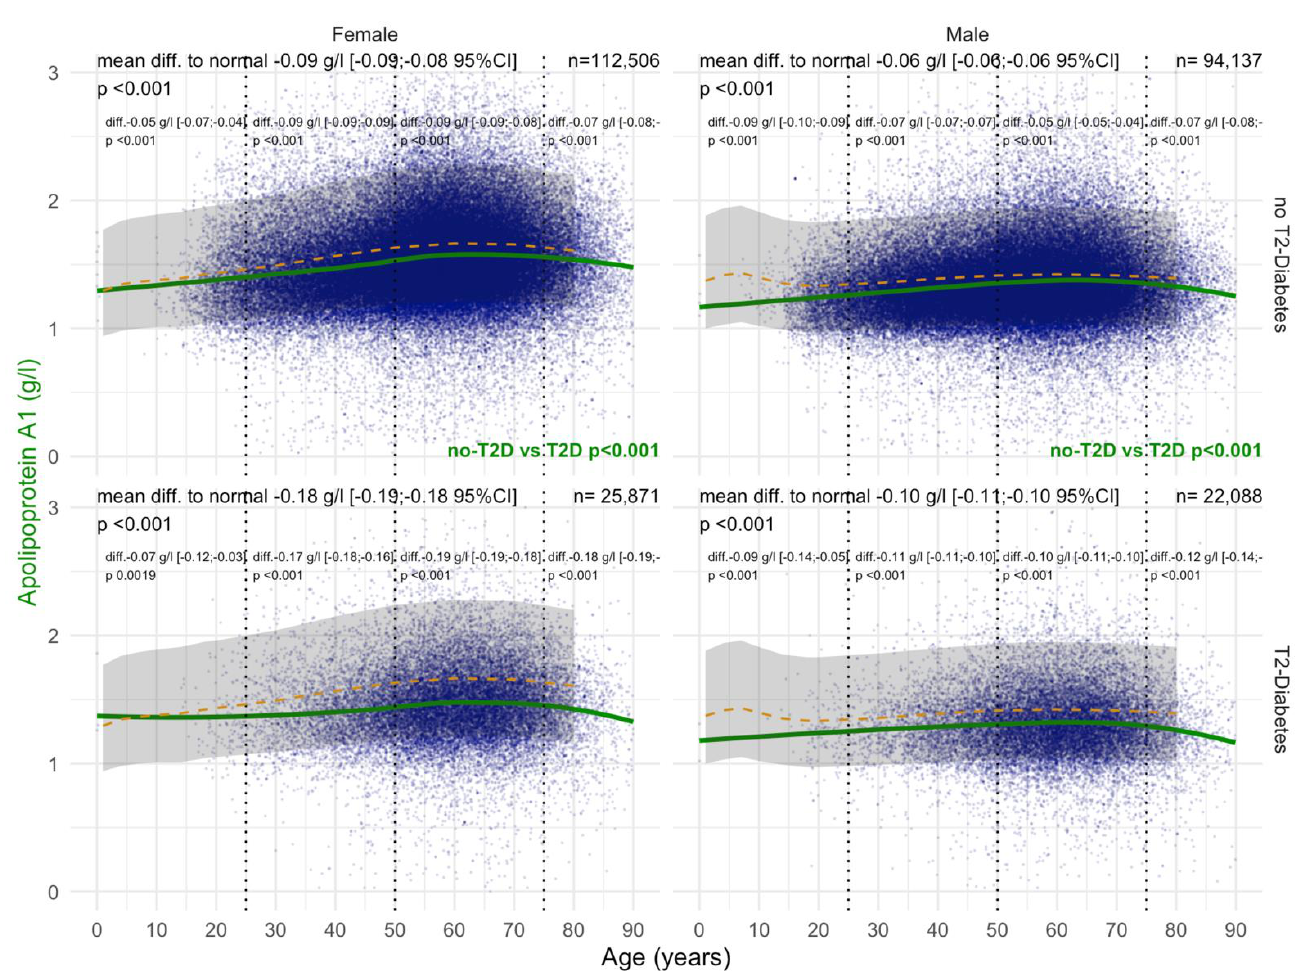
Figure 14. ApoA1 levels before the COVID-19 pandemic. Impact of T2DM on ApoA1 concentration before SARS-CoV-2 pandemic in “ NAFLD-Serum ” patients followed for metabolic liver risk (n = 254,602). Normal serum means values according to age and sex (dashed – orange lines), with 95% confidence intervals (gray ribbon). Three vertical – dotted lines mark the four age groups (before 25, between 25 and 50, between 50 and 75 and above 75 years old). The green curve is a Loess regression of the median of ApoA1 values. For each age group, the mean difference (%95CI) between the patient protein value and the expected normal value (for age and sex) with its significance p -value is displayed at the top of the figure. The significance between the non-T2DM and T2DM patients is displayed in green between the 2 panels.